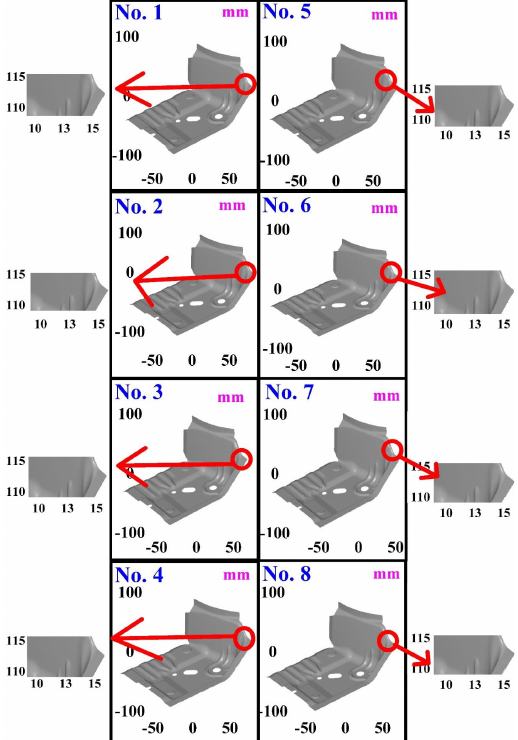
Figure 13. Measurement results of the glossy sheet metal that was not sprayed with a mixture of ethanol and TiO 2 powder.